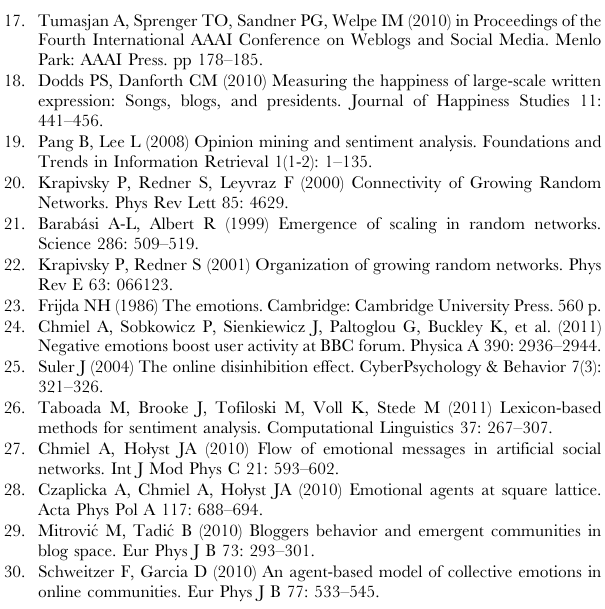
Figure S1 The difference between the actual tree structure (A) present in the BBC and Digg datasets as compared to the chronological layout of the posts (B). The numbers indicate the order of messages (1 being the first, 10 being the last) while arrows indicate that a post was given in reply to another one (e.g. post 9 is the response to post 7). (TIF) Figure S2 In case of the i.i.d. random process to obtain the probability of finding a cluster of exactly n consecutive emotional values (here n ~ 5 and e ~{ 1 ) one has to take into account two factors: the length of the cluster itself and the issue that on the both borders there should be posts with emotional value other than inside the cluster. Thus in the presented case the probability is proportional to 1 { p ( { ) ½ (cid:2) p ( { ) 5 1 { p ( { ) ½ (cid:2) . (TIF) Text S1 Text S1 includes a detailed derivation of the analytical approximation of cluster length distribution as well as comparison of this approach with the i.i.d. random process, Markov chain and k { 1 ð Þ Markov model. It also contains the analysis of the influence of the thread length on the emotional cluster distributions and discussion on the number of unique users in emotional clusters.